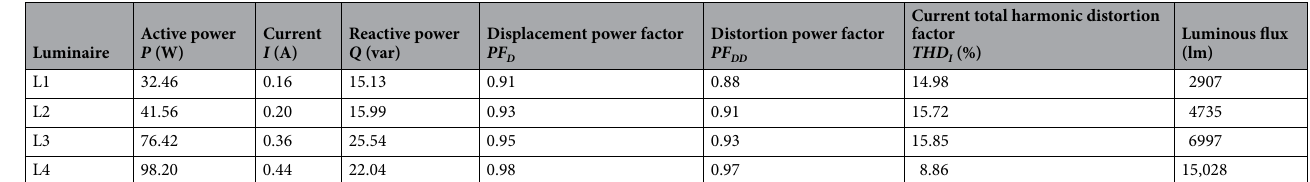
Table 1. Electrical parameters and luminous